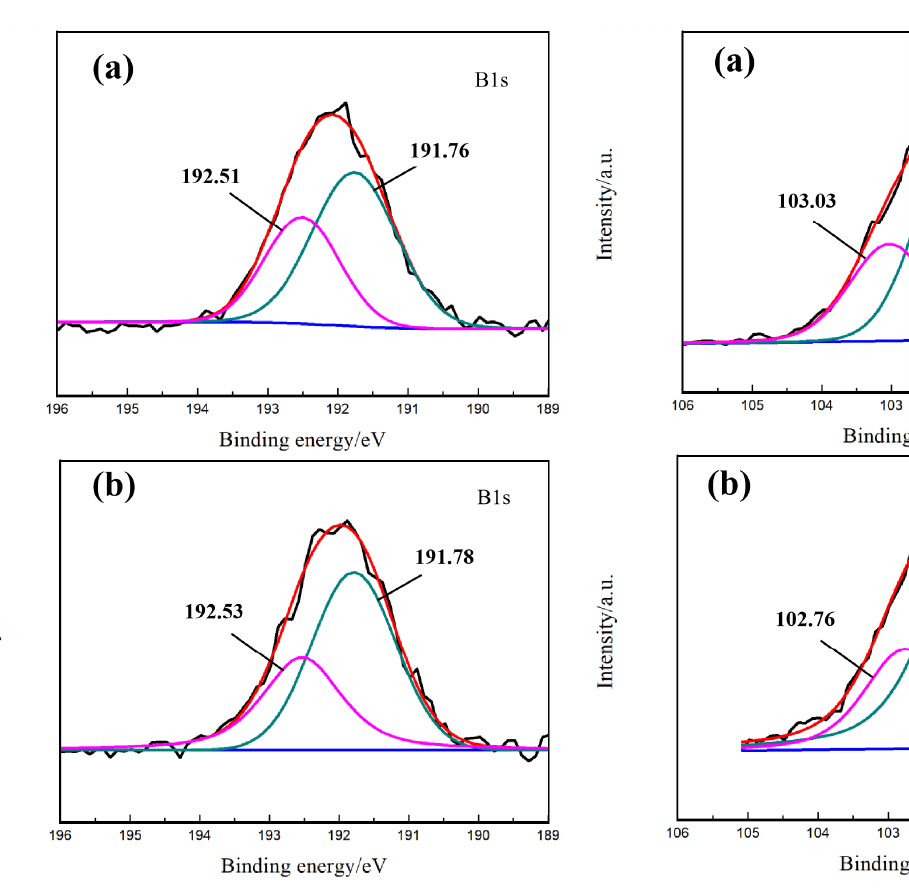
Figure 4: XPS peak differentation imitating analysis of Si(2p): a) flux, b) slag Table 5: XPS analysis of